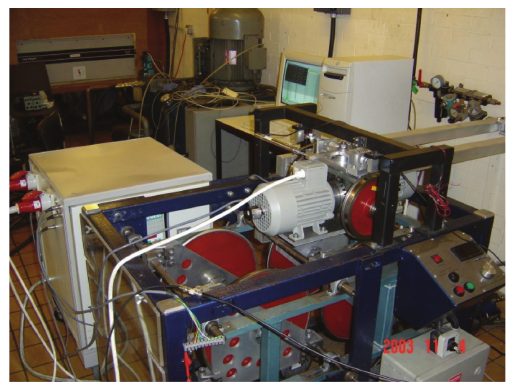
Figure 4: The wheelset and test